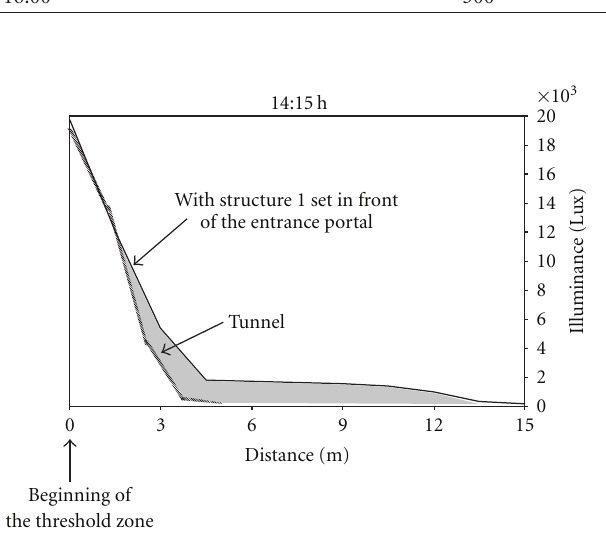
Figure 6: Additional natural light in the threshold zone.